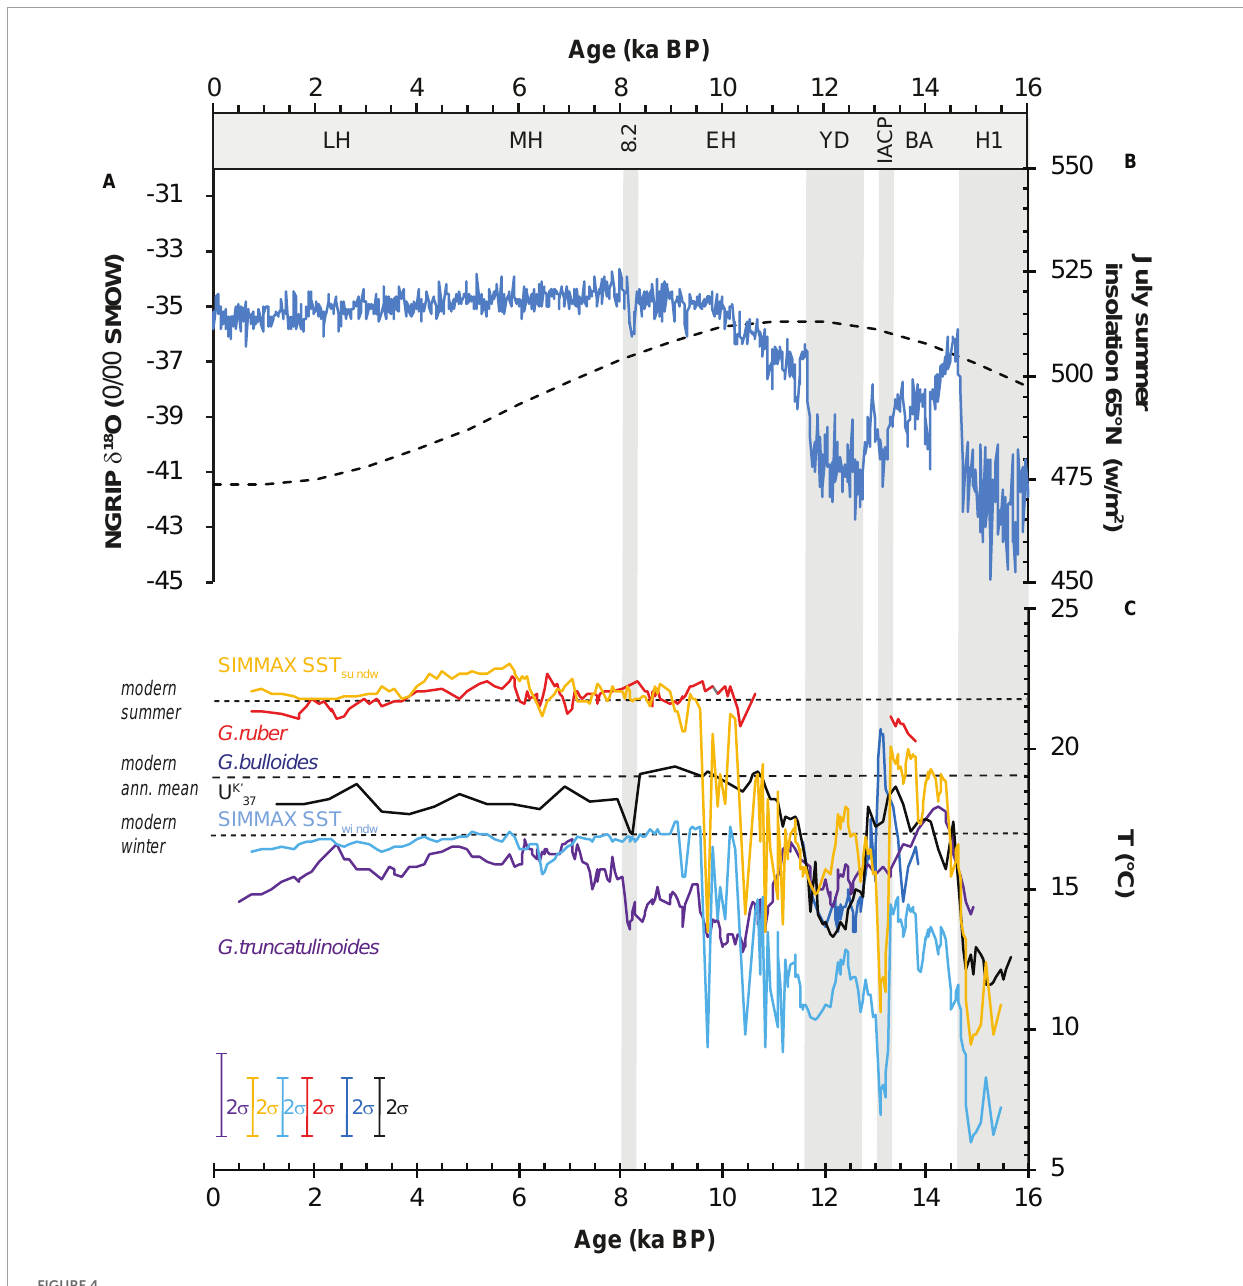
FIGURE4 Comparison of (A) ice core record NGRIP δ 18 O (Andersen et al., 2006), and (B) northern hemisphere summer insolation changes (Berger and Loutre, 1991), with (C) deglacial SST reconstructions based on non-distance weighted SIMMAX summer (yellow) and winter (light blue) SST, Alkenone U K (cid:48) 37 SST (black) (Schwab et al., 2012), and planktic foraminifer Mg/Ca SST (Repschläger et al., 2015, 2017). Lines in Mg/Ca SST records display three-point running mean values. For abbreviations on time axis see Figure 2 , a single data point excursion of 1 ◦ C during the IACP in the U K (cid:48) 37 SST record is not